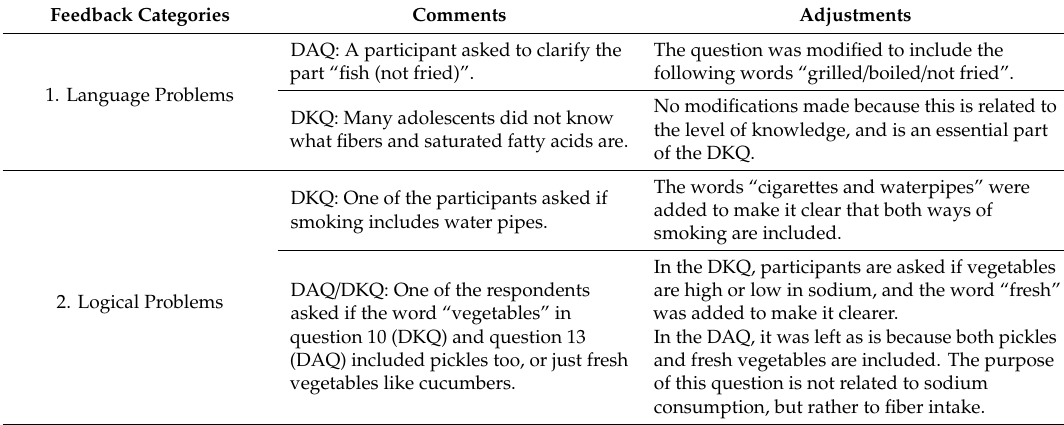
Table 2. List of comments reported by the adolescents and the corresponding adjustments to the questionnaires, based on the cognitive interview results.